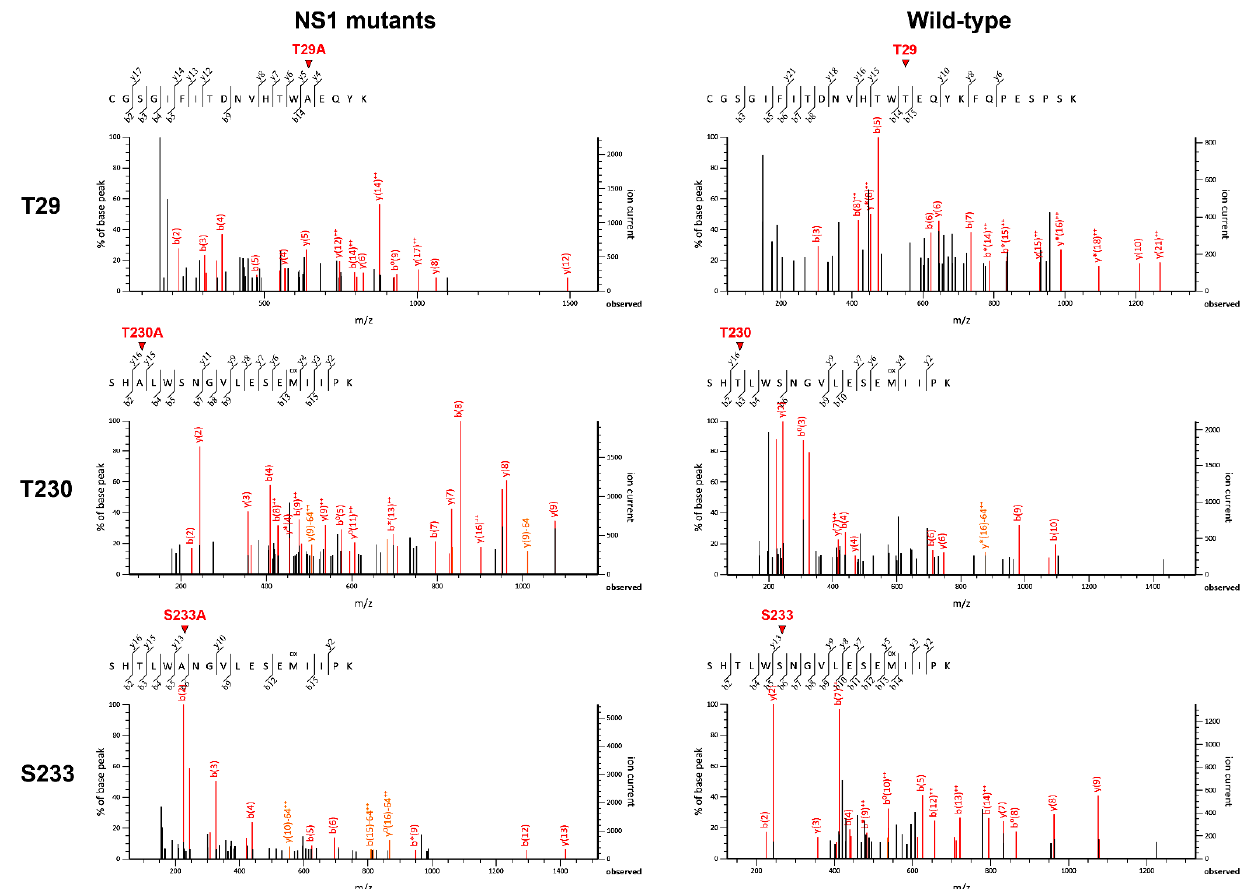
Figure 8. Verification of DENV NS1 phosphorylation mutations by LC-MS/MS. Lysates of Vero cells infected with wild-type DENV or different virus mutants at day 7 post-infection were processed for immunoprecipitation with anti-NS1 antibodies. The immunoprecipitated samples were analyzed by SDS-PAGE and Coomassie Brilliant Blue staining. DENV NS1 protein bands were excised from the gels and further processed for LC-MS/MS to verify the phosphorylation mutations at specific amino acid positions (T29A, T230A, and S233A) of DENV NS1. Three independent experiments were conducted. Representative results of de novo peptide sequencing show the substitution of Thr29, Thr230, and Ser233 with alanine in DENV NS1 protein derived from T29A, T230A, and S233A mutants (left panel) as compared with that from wild-type DENV (right panel).